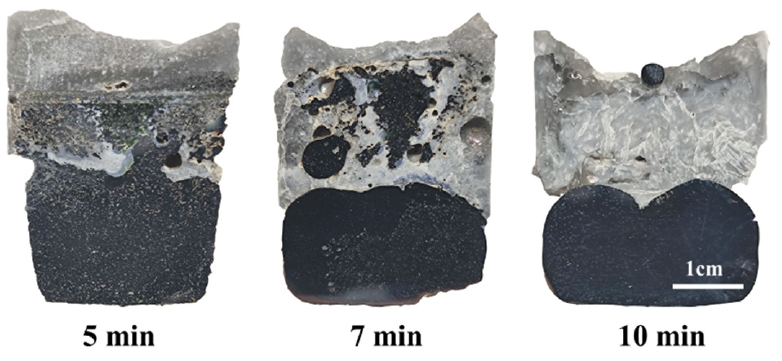
Figure 2. Sectional photos of the samples (Fe-5 mass % Al Alloy and high SiO 2 flux) quenched after reacting at 1873 K for 5, 7, and 10 min.